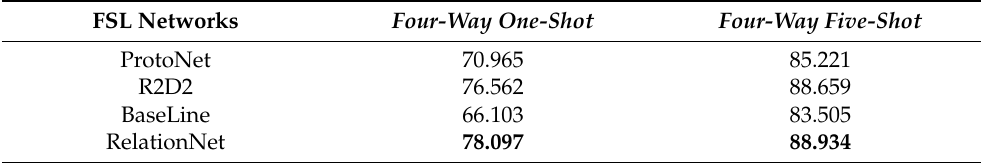
Table 6. Statistical results obtained from RelationNet (%) (the best results in